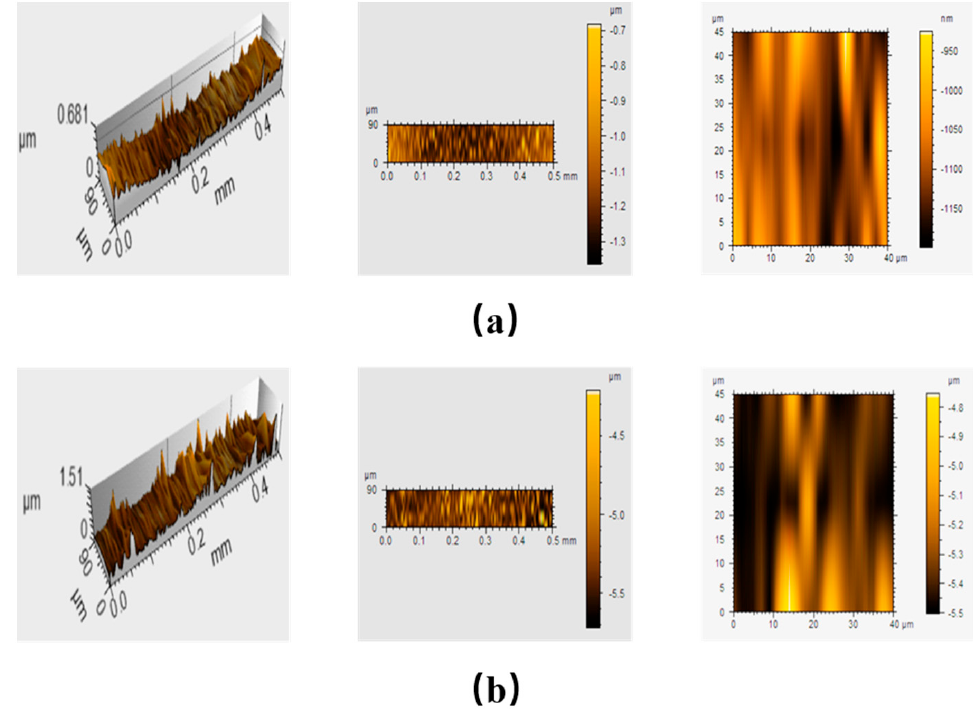
Figure 8. Surface structure images of ( a ) PET-PAni and ( b ) PET-PAni-CoFe 2 O 4 (50%) measured by stylus profiler.